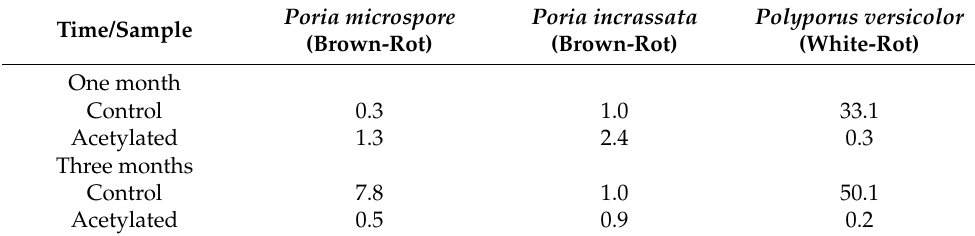
Table 1. Weight loss (%) in balsa after soil test with fungi [6].